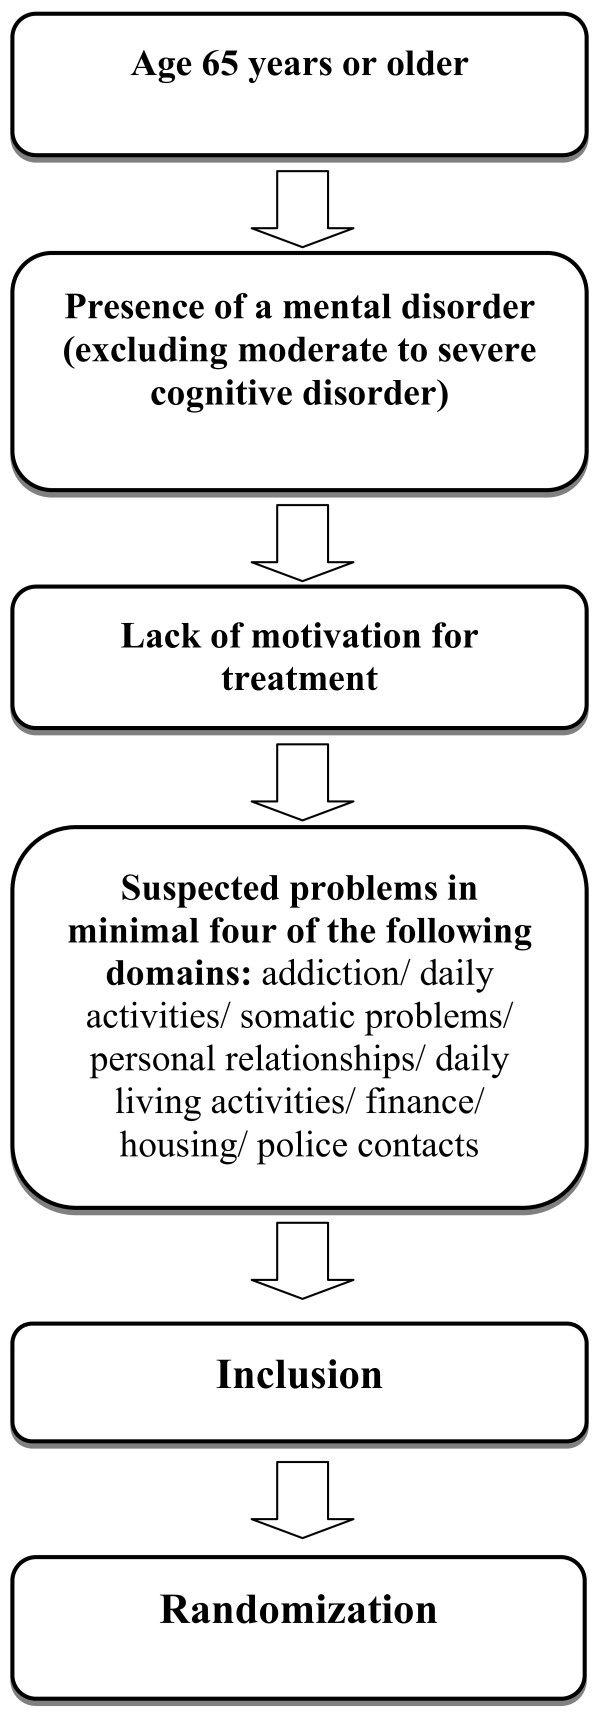
Inclusion flowchart.